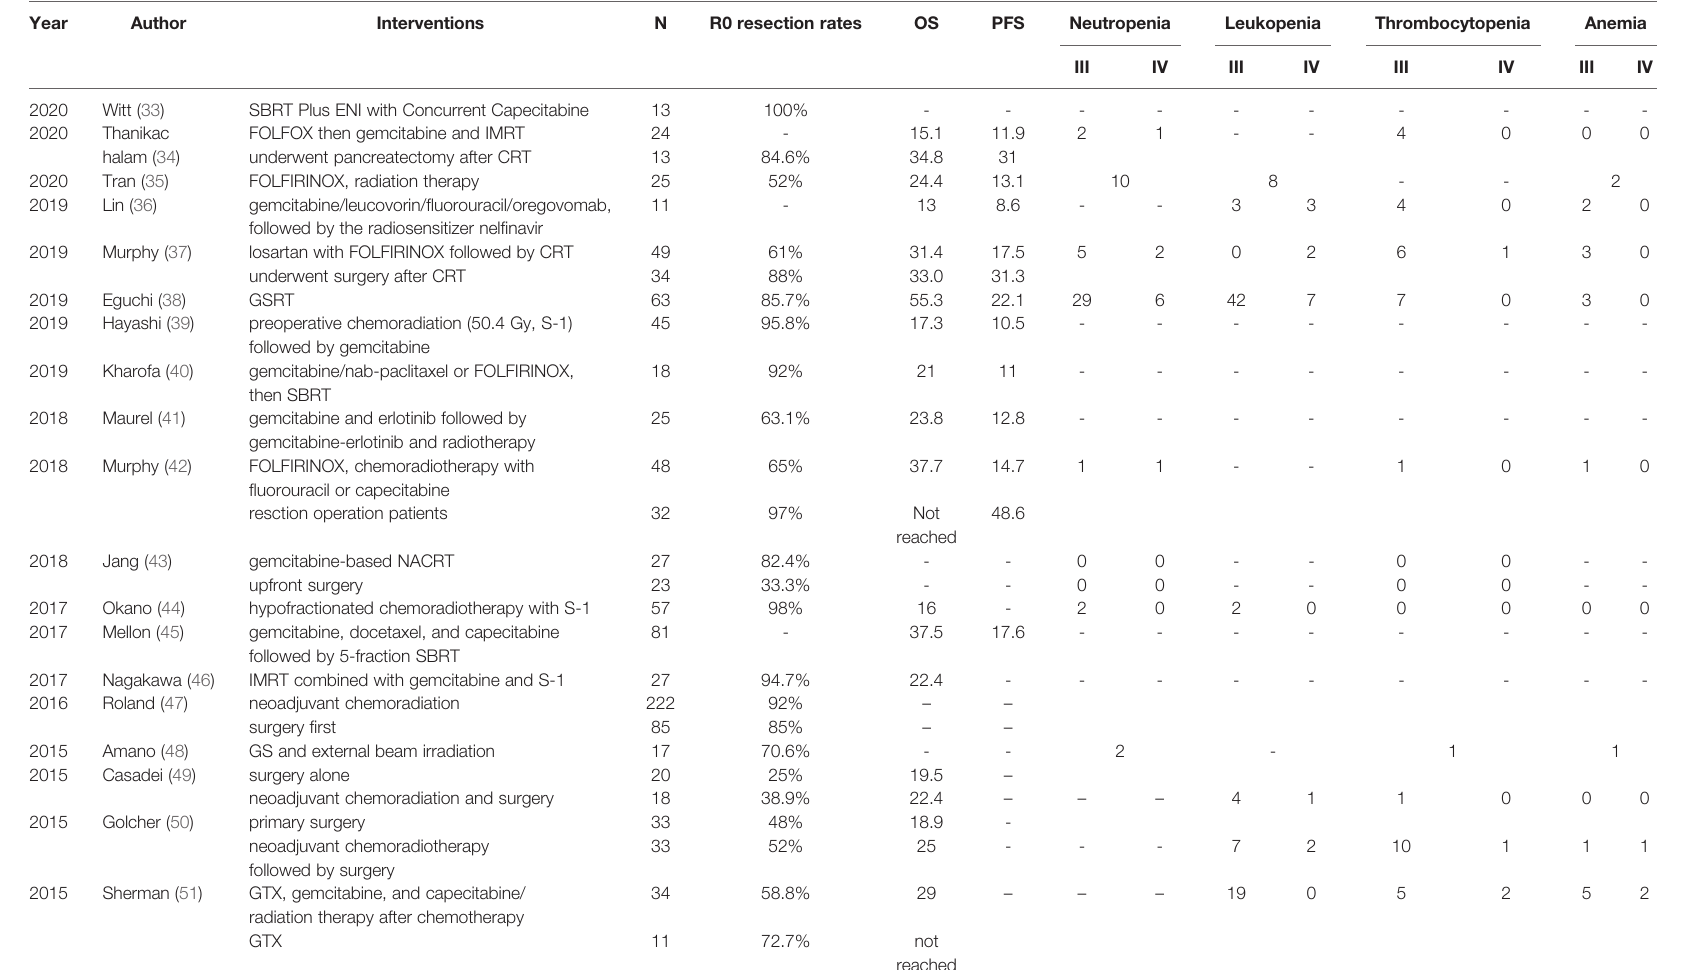
TABLE 3 | Clinical trials with NACRT on advanced pancreatic